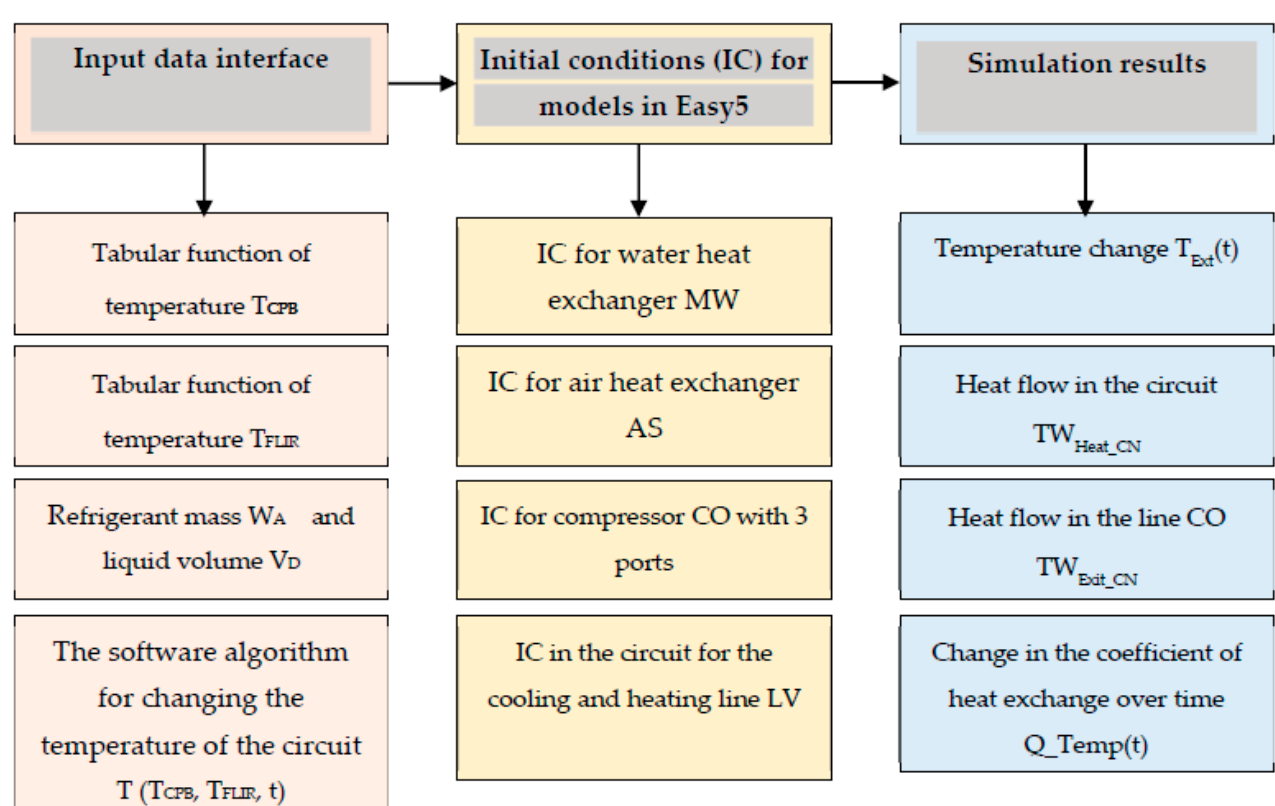
Figure 1. Application of the MSC Easy5 system for modelling the temperature control circuit in the CPB heat exchanger.